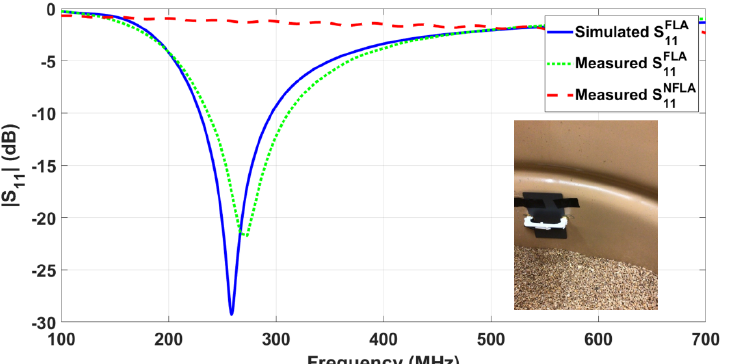
Figure 5. Simulated and measured the magnitude of the reflection coefficient of FLA and measured the reflection coefficient of NFLA. The photo of the installed FLA inside the metallic bin has been shown in the bottom right side of the plot,